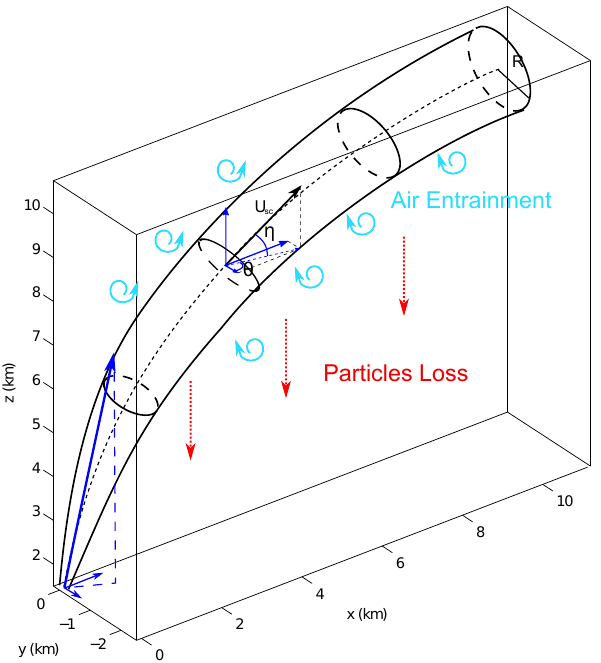
Figure 1. Schematic representation of the Eulerian plume model. The dashed black line represent the axis of the curvilinear coordi- nate s